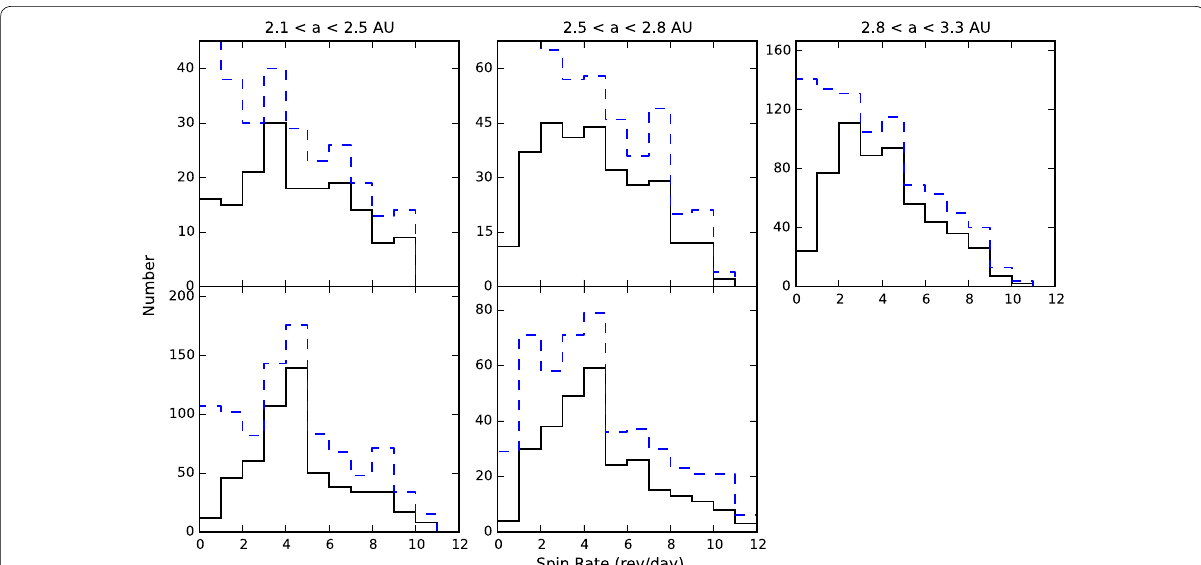
Fig. 6 Spin‑rate distributions of the 20‑min cadence surveys. The spin‑rate distributions for asteroids of 3 < D < 15 km ( upper ) and D < 3 km ( lower ) at inner ( left ), middle ( center ), and outer ( right ) main belt. The solid black line and blue dashed line are the original and de‑biased results, respectively. The number of asteroids used in each distribution is indicated in each plot. Note that the number of asteroids of D > 15 km and that of D < 3 km in outer main belt are too small to carry out meaningful statistics. This figure is reproduced from Chang et al. (2015)